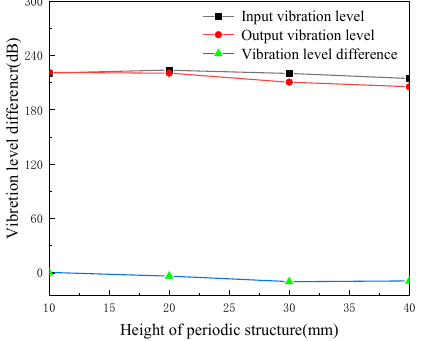
Figure 11. The effects of periodic structure height on cushioning performance (periodic structure width of 40 mm).